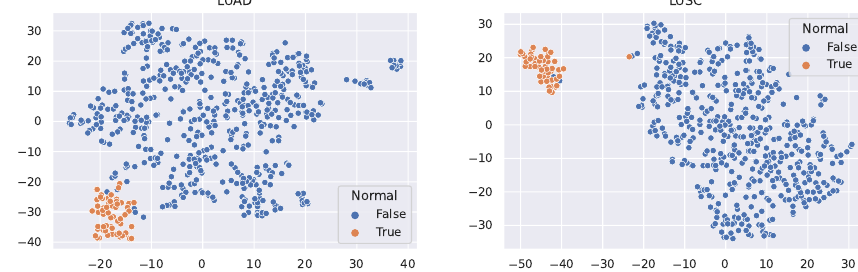
Figure 5. t-SNE visualisation of LUAD and